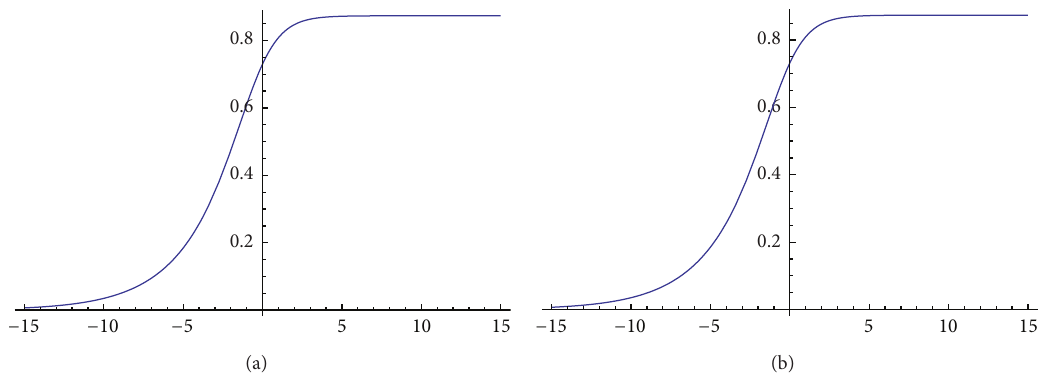
Figure 12: Two-dimensional graph of the solution (41) corresponding to the values 𝛼 = 0.05 , 𝛼 = 0.85 , respectively, when 𝑘 = 1 , 𝑝 = 3 , 𝛽 = 2 , 𝑡 = 1 , and −15 < 𝑥 < 15